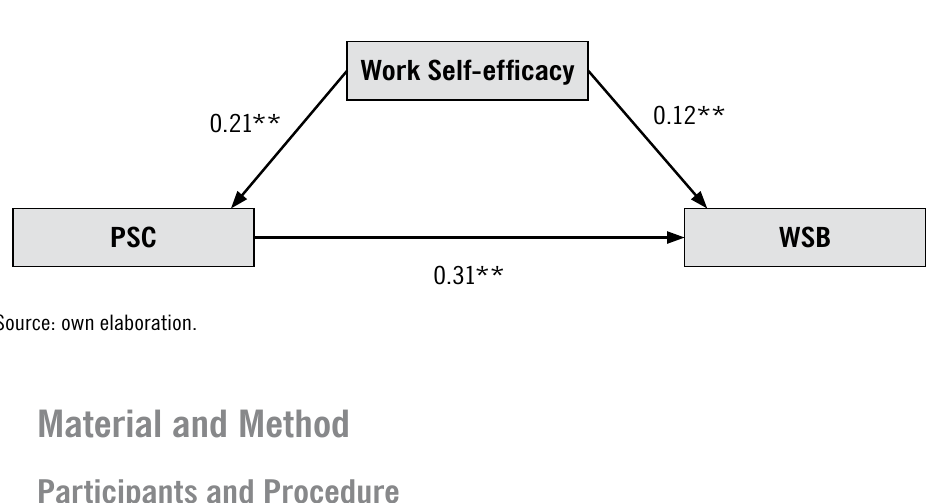
Figure 1. Theoretical research model for the study